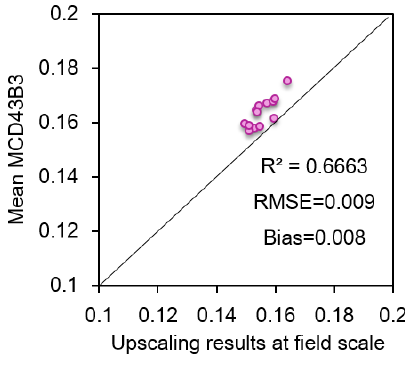
Figure 14. Scatterplots between the mean MCD43B3 and upscaling results in the field